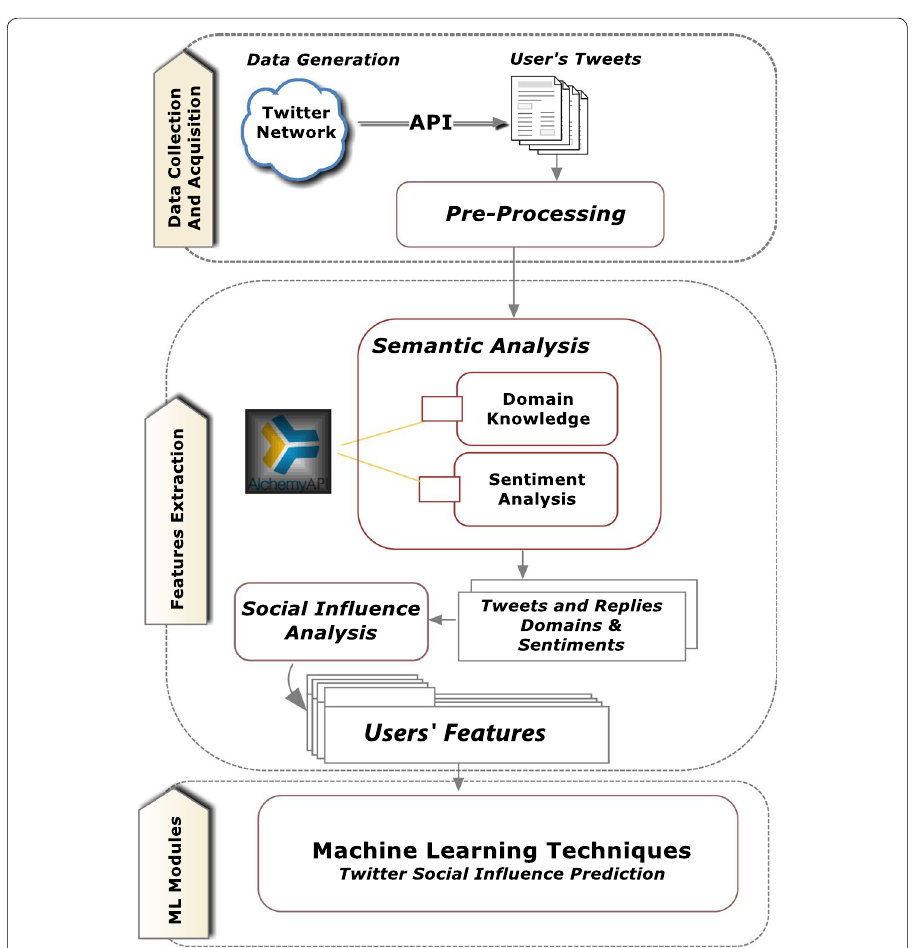
Fig. 1 System architecture development